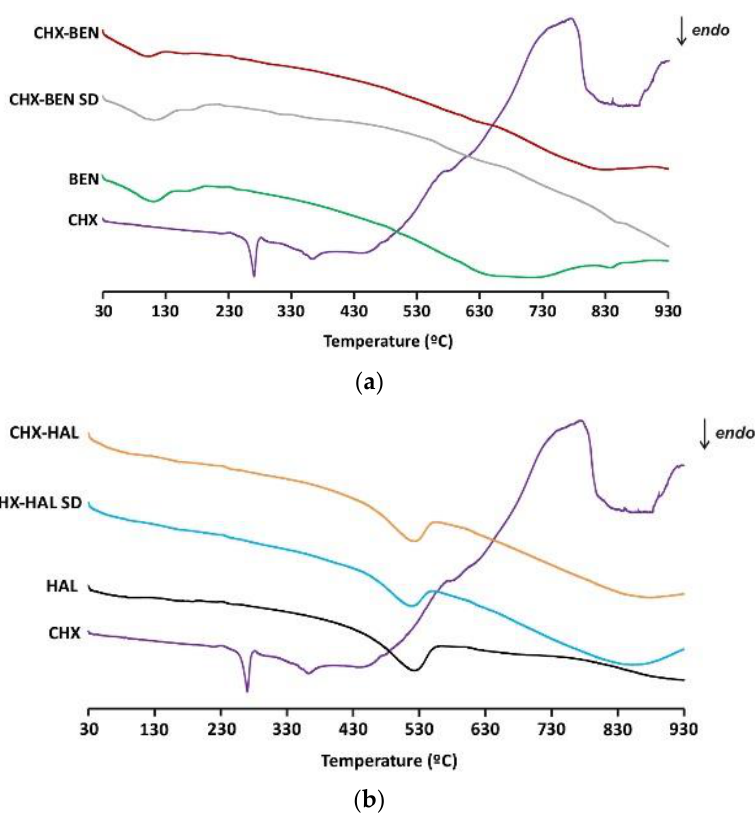
Figure 5. DSC curves of nanohybrids and pristine components: ( a ) BEN-based nanohybrids; ( b ) HAL-based nanohybrids. CHX: chlorhexidine dihydrochloride; BEN: bentonite; HAL: halloysite; CHX – BEN and CHX – HAL: nanohybrids obtained by intercalation solution technique; CHX – BEN SD and CHX – HAL SD: nanohybrids obtained by spray-drying technique.